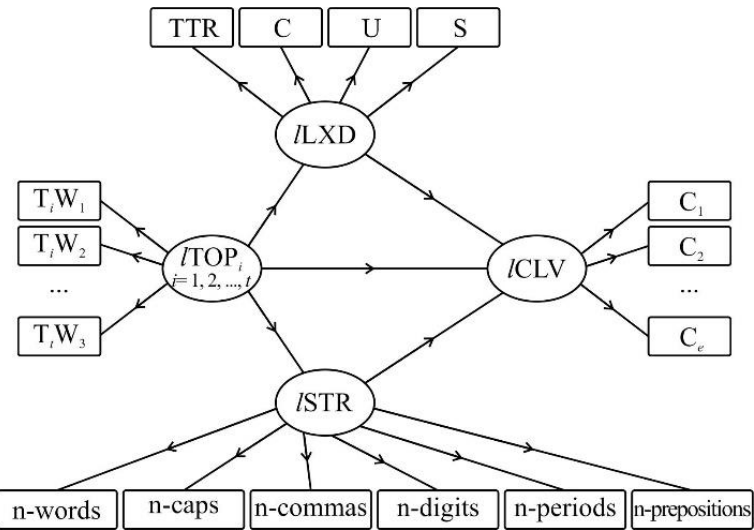
Figure 2. Measurement and Structural Model accounting for influences of Topics on Lexical Diver- sity- lLXD , Structuring Skill lSTR and lCLV (Competence Level). lLXD , Structuring Skill lSTR and lCLV (Competence